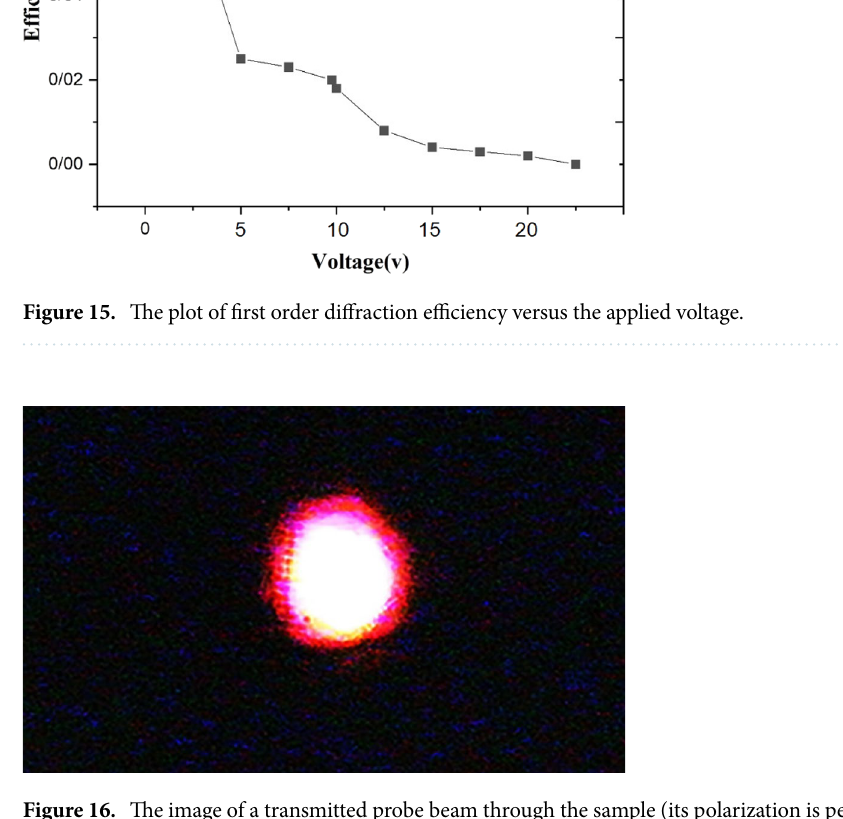
Figure 16. The image of a transmitted probe beam through the sample (its polarization is perpendicular to the cell alignment) at 0 v applied